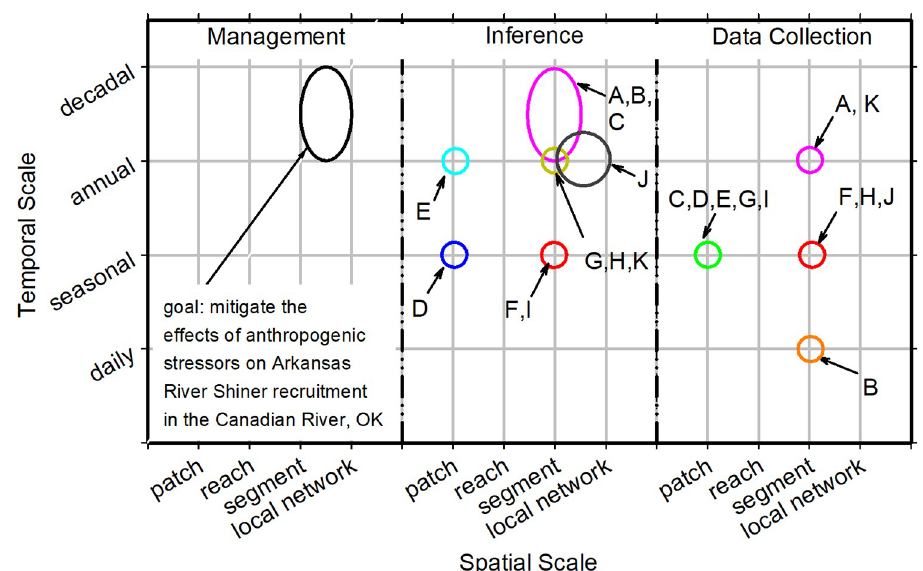
Fig 5. The spatial and temporal scales of the management goal, the scientific inferences needed to inform the management goal, and that data collection needs to occur to support the inferences for monitoring information needs identified as requiring additional data in the case study addressing the recruitment of the Arkansas River Shiner in the Canadian River, Oklahoma (see S1 Table for additional detail). A:Tier 1 EEC = channel morphology/ hydraulics; Stressor = altered hydraulic regime; B:Tier 1 EEC = biogeochemistry/thermodynamics; Stressor = altered water temperature regime; C:Tier 1 EEC = biogeochemistry/thermodynamics; Stressor = altered biogeochemical regime; D:Tier 2 EEC = Arkansas River Shiner spawning habitat; Stressors = contaminants, water temperature, habitat fragmentation; E:Tier 2 EEC = larval Arkansas River Shiner habitat, Stressors = water temperature, habitat fragmentation and Tier 2 EEC = invertebrate habitat, Stressors = altered riparian plant community, discharge, sediment deposition; F:Tier 3 EEC = primary production, Stressor = nutrient flux; G:Tier 3 EEC = invertebrate production; Stressor = invertebrate habitat quantity and quality and Tier 3 EEC = Arkansas River Shiner larvae production, Stressor = predation by invasive species; H:Tier 1 EEC = biogeochemistry/thermodynamics; Inter-tier interaction = Sediment adsorption of contaminants and nutrients and Tier 3 EEC = Arkansas River Shiner larvae production, Stressors = Arkansas River Shiner larvae habitat quantity and quality and Tier 3 EEC = Arkansas River Shiner age-0 recruitment; Inter-tier interaction = Arkansas River Shiner larvae mortality and Tier 3 EEC = Arkansas River Shiner age-1+ recruitment, Inter-tier interaction = Arkansas River Shiner age-0 mortality and Tier 3 EEC = all, Inter-tier interaction = trophic level interactions; I:Arkansas River Shiner larvae production; Stressor = direct mortality from recreational use (i.e., all-terrain vehicle and in-river traffic); J:Tier 3 EEC = Arkansas River Shiner egg quality and production; Stressor = Arkansas River Shiner spawning habitat quantity and quality; K:Tier 3 EEC = Arkansas River Shiner larvae production; Inter-tier interaction = Arkansas River Shiner egg